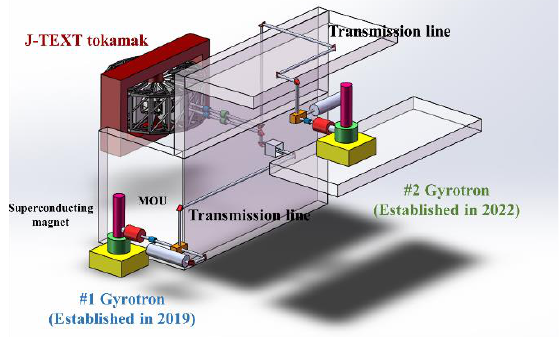
Fig. 1. Layout of J-TEXT 1 MW ECRH system